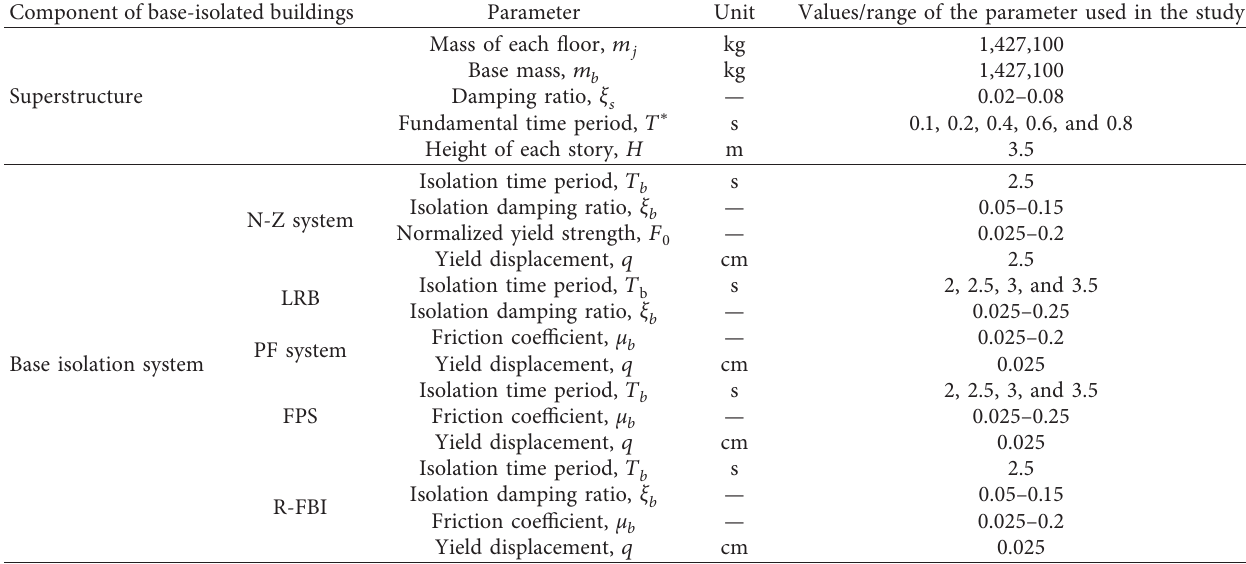
Table 1: Properties of the superstructure and isolation systems of base-isolated buildings. Component of base-isolated buildings Parameter Unit Values/range of the parameter used in the study